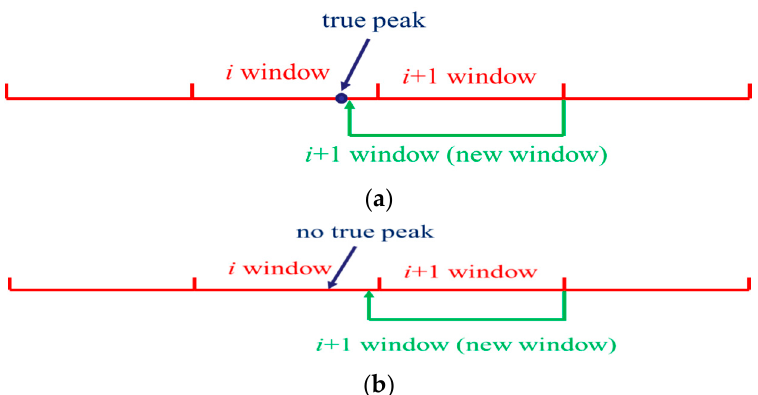
Figure 10. Schematic diagram of the variable sliding window: ( a ) The i ( i ≥ 1) window contains a peak ( b ) The i window does not contain a true peak. Note: the green arrows indicate the starting point of new